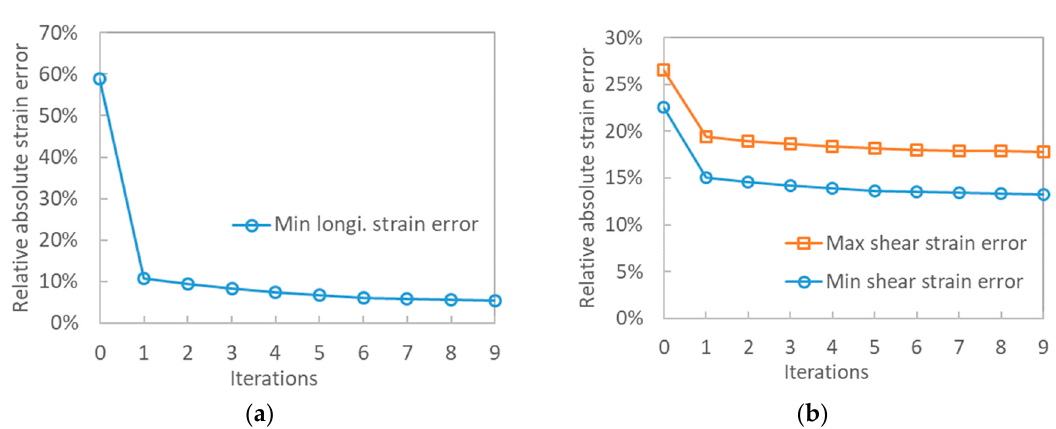
Figure 14. Relative absolute strain error between FEM and DIC data for ( a ) the minimum longitudinal strain and ( b ) the maximum and minimum shear strain value in the DIC region of